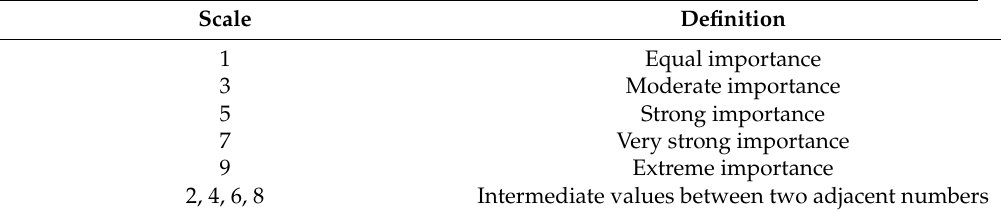
Table 2. Saaty’s 1-9 scale of the relative importance [31,74].